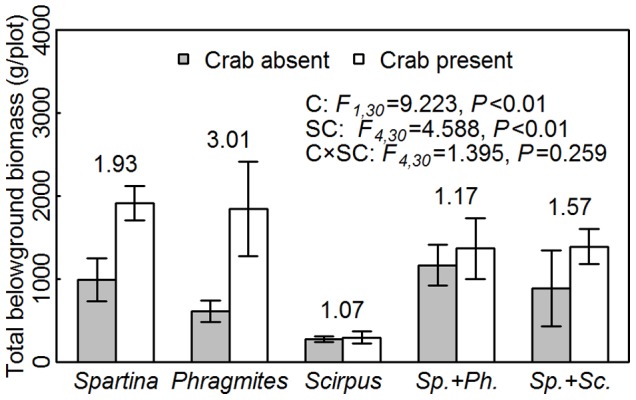
The total belowground biomass (mean ± SE) with/without crab disturbance in five species combinations.The categories on X axis present different species combinations. “Sp.”, “Ph.” and “Sc.” are abbreviations for “Spartina”, “Phragmites” and “Scirpus”, respectively. The F-values and P-values of the effects of crabs and five species combinations on belowground yield are given, where “C” stands for crab treatments and “SC” stands for species combinations. The Rcrabs of three species in specific species combinations are given above the bars.